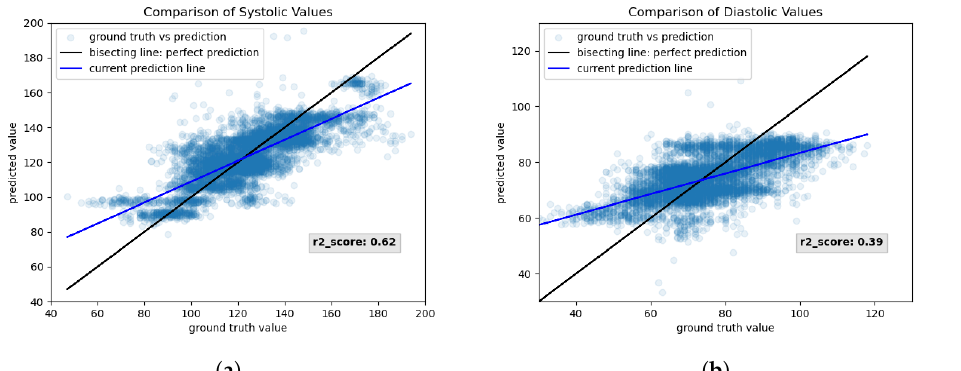
Figure 22. Results of training neural network with 25 input nodes, two hidden layers with 45 and 10 nodes, respectively, and 2 output nodes. Used correlation threshold for filtering: 0.7. Regular- ization: L1 regularization on input features. ( a ) Scatter plot of systolic values. ( b ) Scatter plot of diastolic